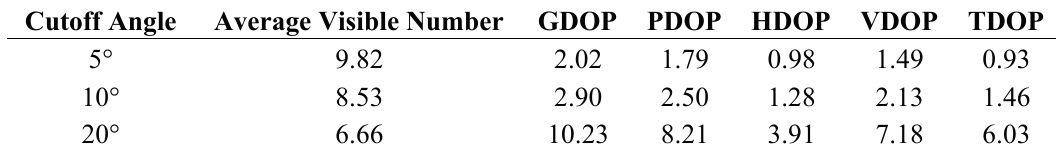
Table 2. Average visible number of satellite and DOPs at different cutoff angles.